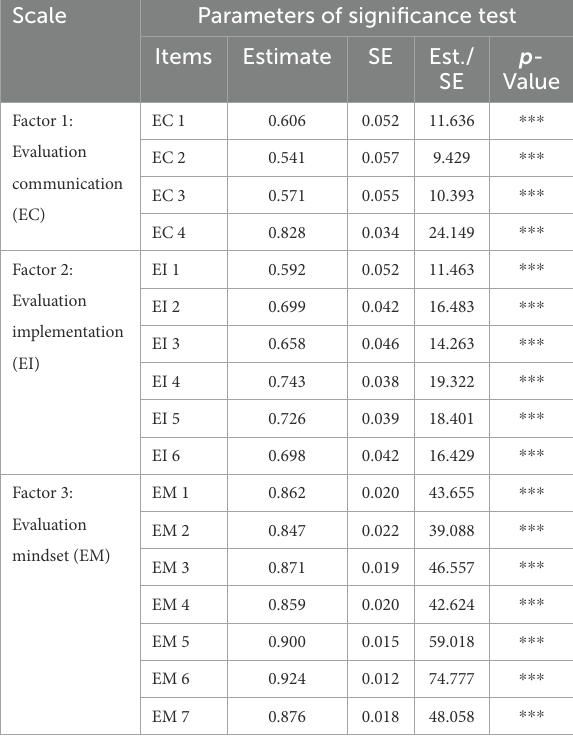
TABLE 3 Factorial validity ( n = 202).